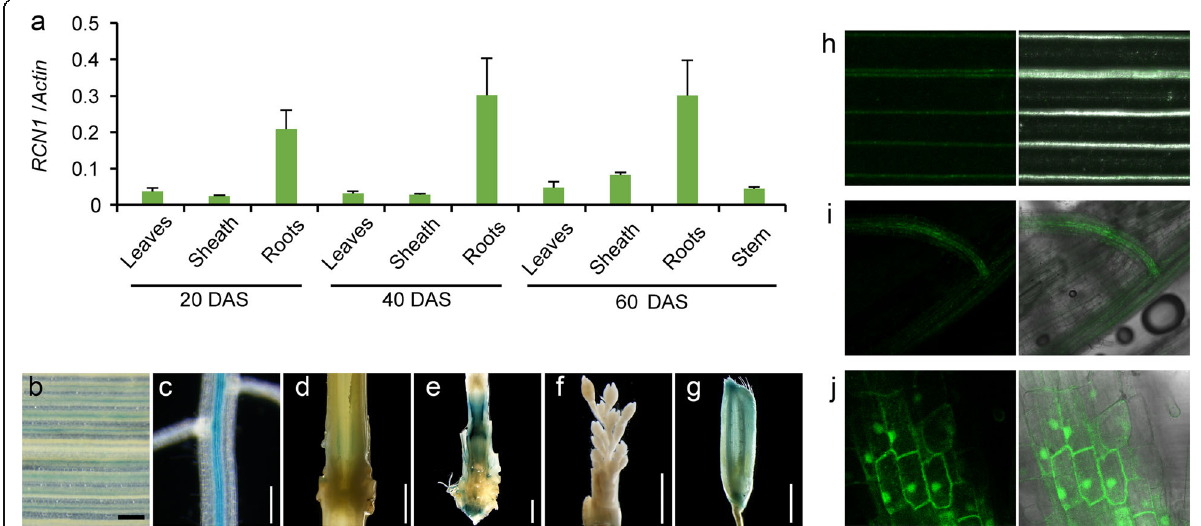
Fig. 1 Expression patterns of RCN1 in rice. Expression of RCN1 RNA in rice ( a ). RCN1 expression was analyzed by quantitative real-time PCR throughout the growth period. Actin RNA was used as the control. DAS: days after seeding. GUS staining images of pRCN1::GUS:NOS in transgenic rice leaf ( b ), root ( c ), stem node ( d ), basal internodes ( e ), young panicle ( f ), and glume ( g ). The localization of the RCN1-GFP protein was visualized in confocal images of the leaf ( h ) and root ( i ) in pRCN1::RCN1-GFP:NOS transgenic rice plants, and the subcellular localization of the RCN1-GFP protein was visualized lateral root cells ( j ). Bars = 100 μ m (for b - c ), 1 mm (for d - g